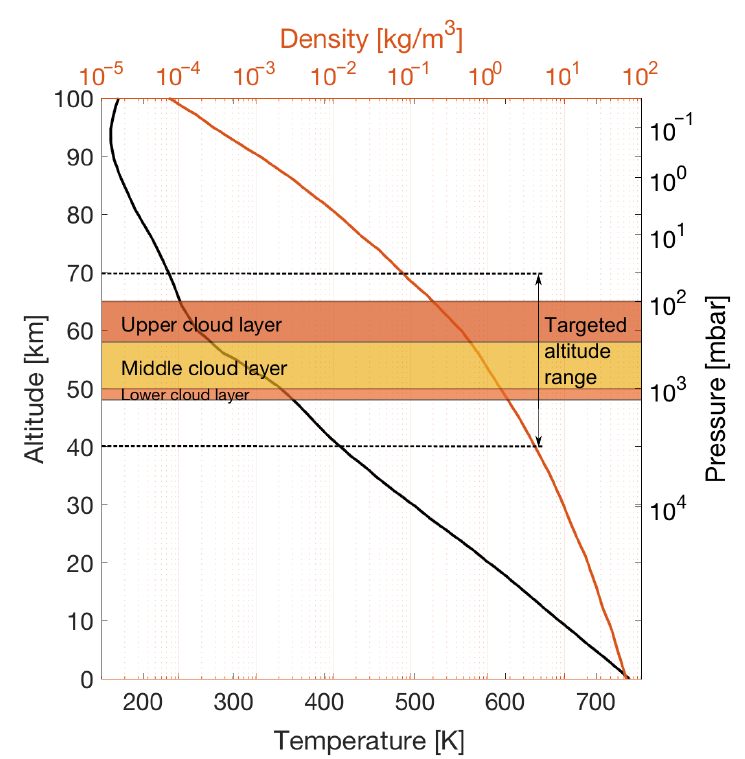
Figure 3. Atmospheric density (red line) and temperature (black line) versus altitude and pressure, based on the VIRA model. Figure adapted from Figure 1 in